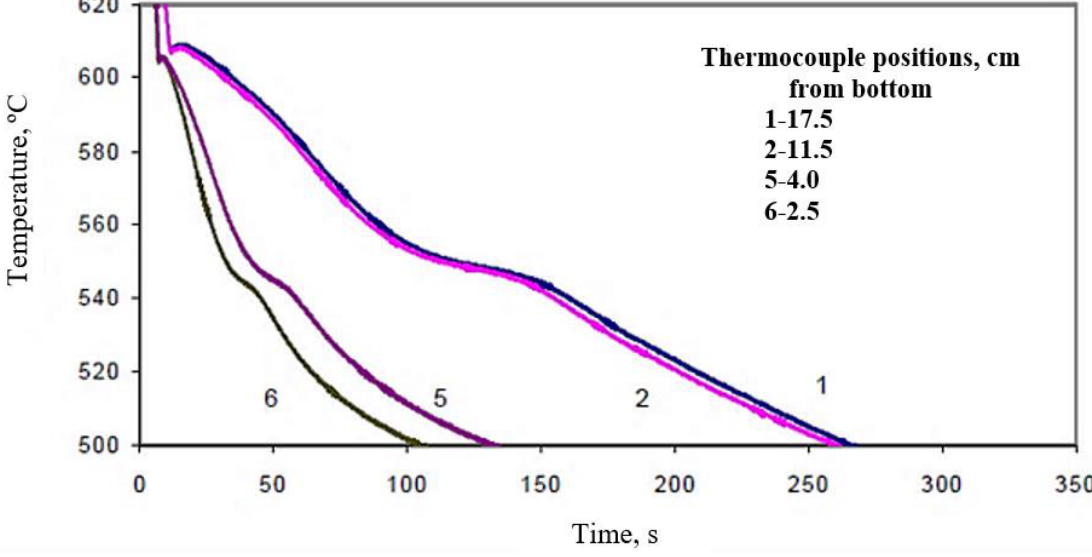
Figure 14. Solidification curves obtained for CC2 alloy (C alloy +94 ppm Ca, large mold).